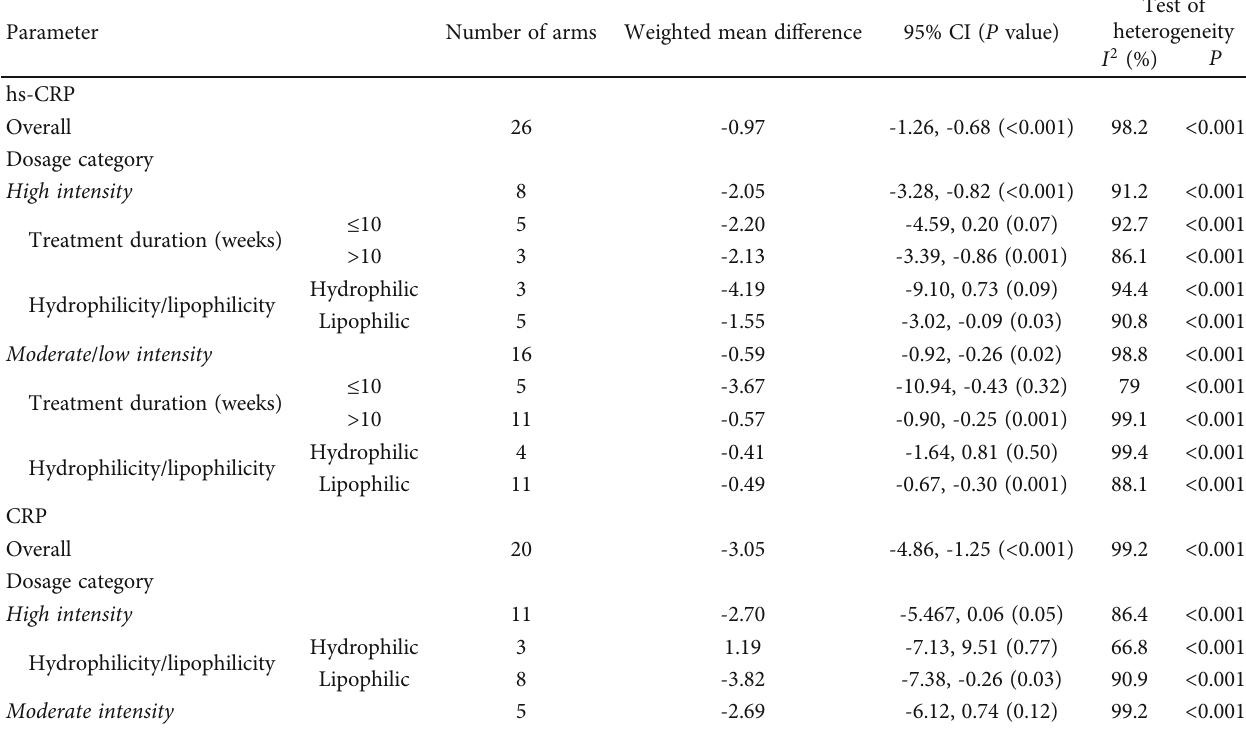
Table 2: The e ff ects of statin therapy on hs-CRP and CRP levels in overall population and subgroup analyses.